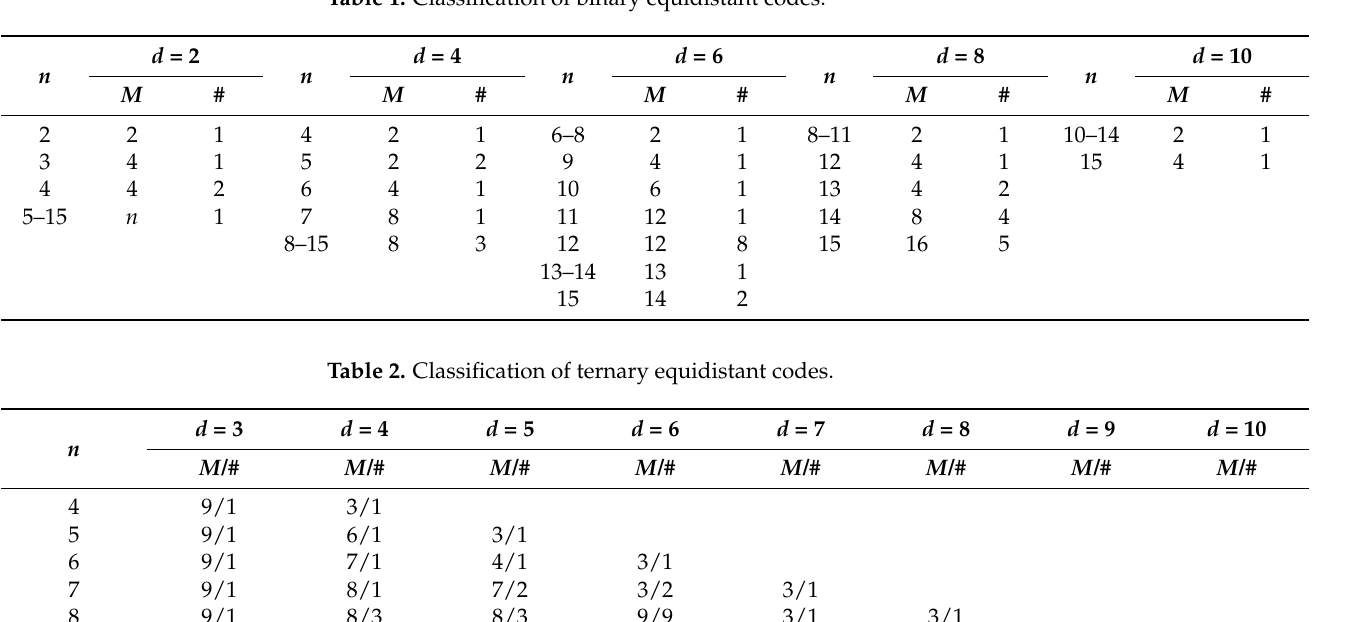
Table 1. Classification of binary equidistant codes.